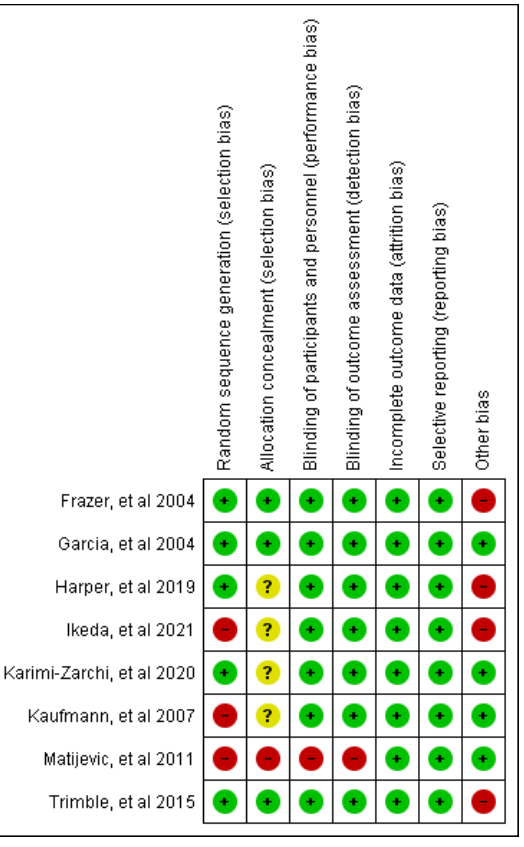
Figure 3. Risk of bias summary: review author's judgments about each risk of bias item for each included study.